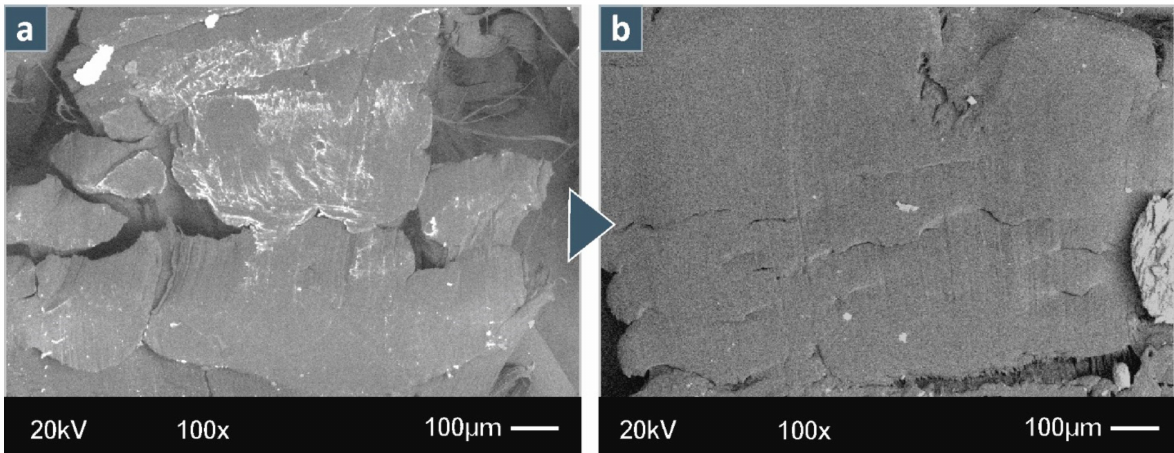
Figure 7. SEM images of ( a ) HDPE unfilled materials’ printed specimen fracture area, ( b ) HDPE unfilled materials’ printed specimen side area.